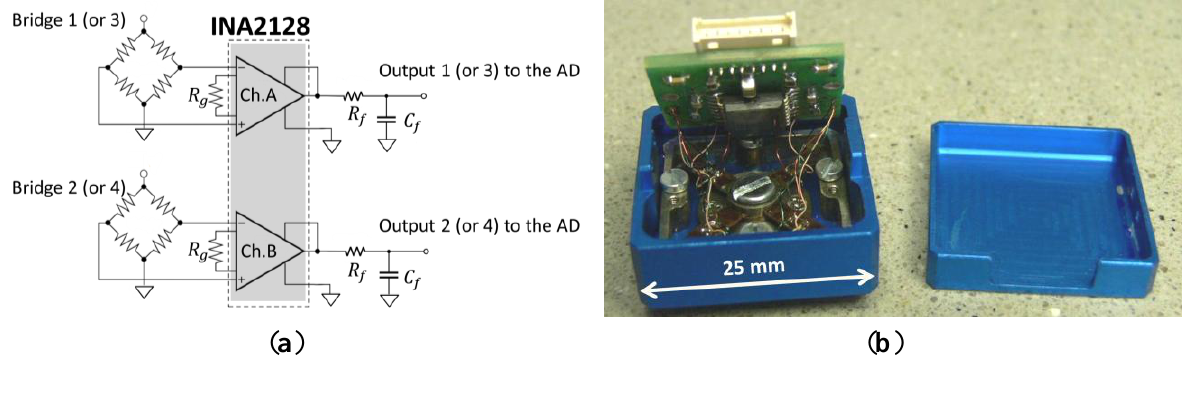
Figure 12. Scheme of the one half of the signal conditioning electronic circuit with R gain regulation resistance; R force sensor assembly with the integrated electronics, raised to show the strain gauges cabling ( b ).